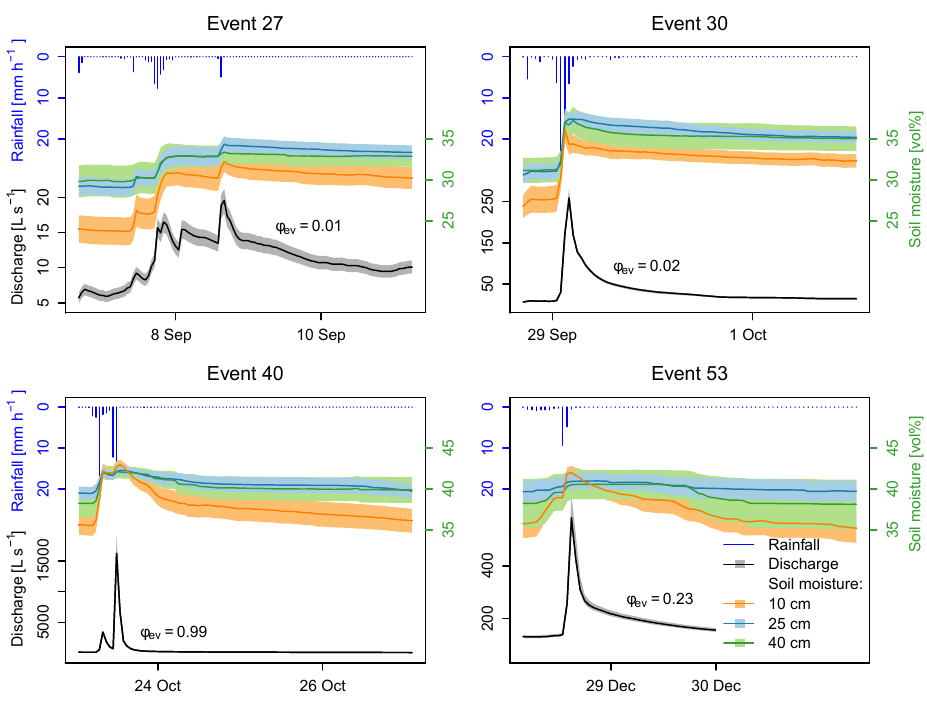
Figure 8. Hyetographs, hydrographs of total discharge and evolution of soil moisture in the Gazel catchment during four different events in 2013. The event-based runoff coefficient φ ev is also given for all events. The representation of soil moisture gives the mean ± SEM inter cat . in the respective depth and that of discharge the best estimate ± the uncertainty of the stage–discharge relation.